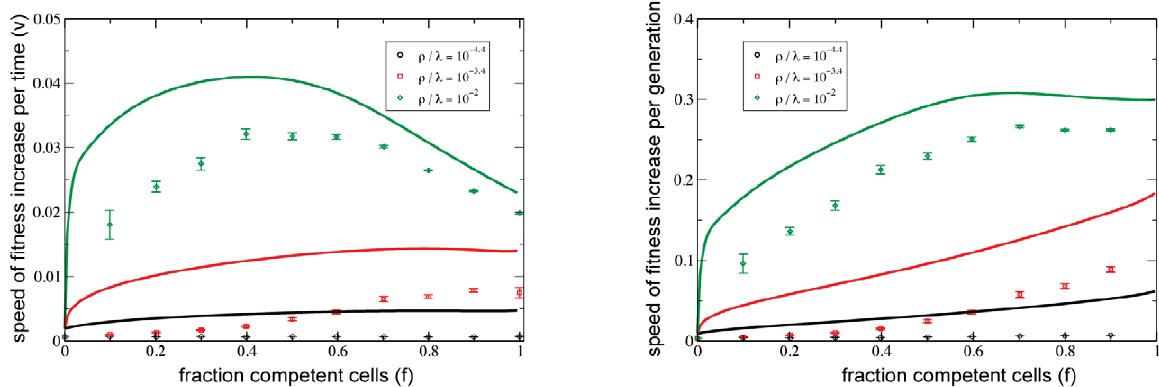
Figure 4. Optimal mixed strategy for competence. If HGR is strong enough, the rate of adaptation ( v ) is maximized when only a finite fraction ( 0 v f v 1 ) of cells express competence at any moment (left). Competent populations are favored because they perform HGR, but disfavored because of their longer generation time. This latter effect is normalized out by considering the speed of evolution per generation (right). The tradeoff then disappears and v gen is maximized by a purely competent population. However, v (and not v gen ), is the evolutionarily relevant measure. Phenotypic diversity is maintained via the switching rates ( s in , s out ) : The fraction of cells expressing competence at any moment was adjusted by varying the rate of competence initiation s in , while s out ~ 0 : 033 . Speeds were determined over 50 replicates and ‘‘shuffled’’ initial conditions were used. Error bars denote one standard error of the mean. Parameters are the same as in figure 2. Clonal initial conditions result in similar qualitative behavior and are explored in figure